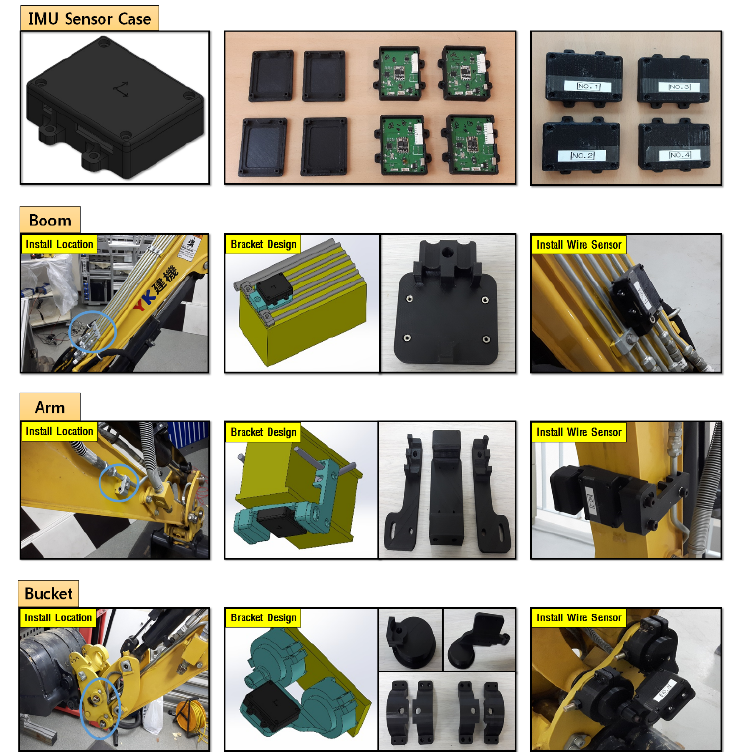
Figure 9. Developed brackets for IMU sensors and status of the installation.